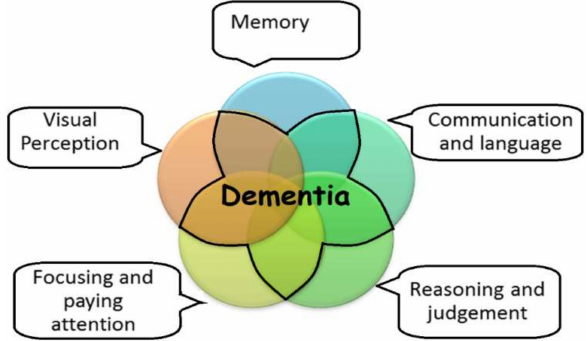
Figure 1. Five core symptomatic areas linked to